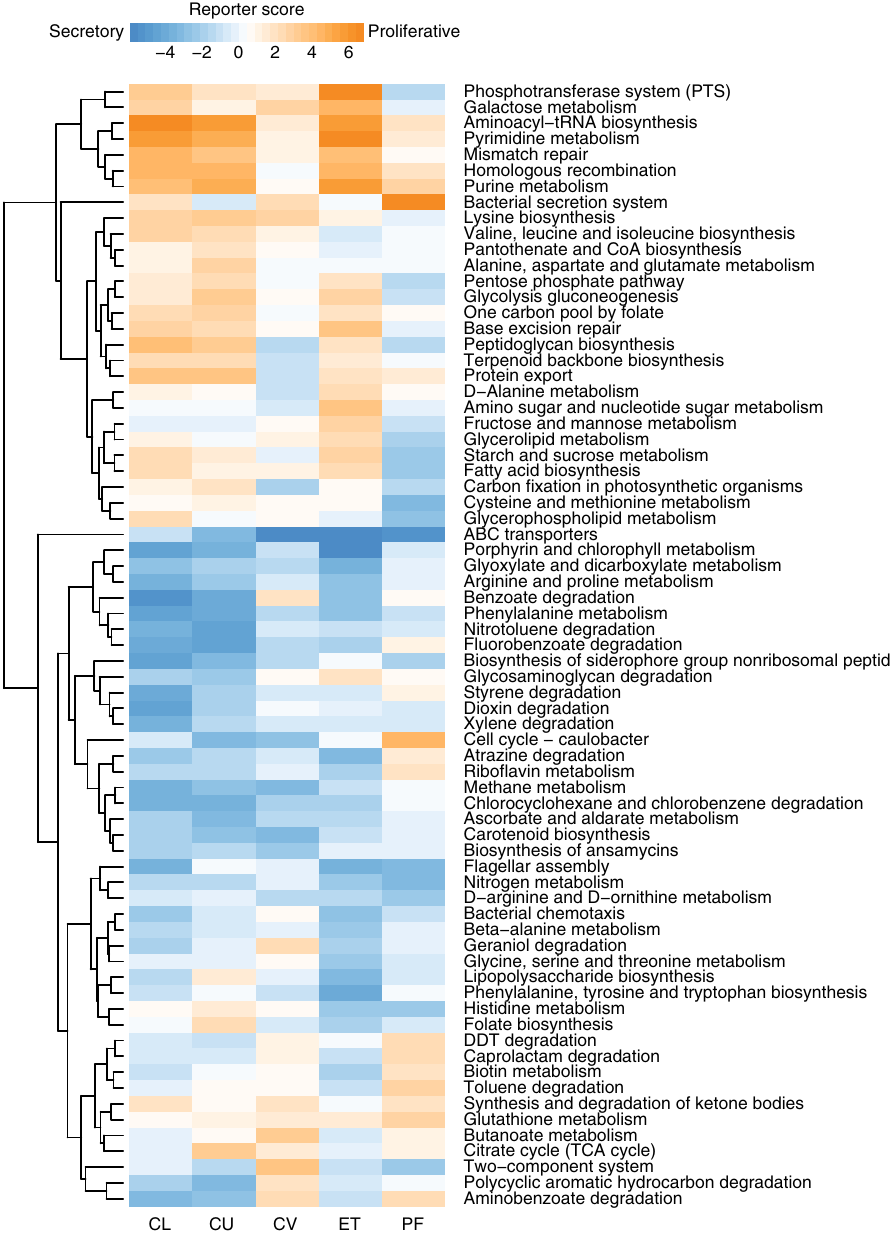
Fig. 6 Associations between inferred microbial functions and menstrual phases. Microbial KEGG pathways enriched in the proliferative or the secretory phases (orange versus blue, reporter score > 1.96 or < − 1.96) and present in all the body sites were plotted as a heatmap. The pathways were arranged by unsupervised hierarchical clustering. Samples derive from the study cohort of 95 reproductive-age women ( n = 94 CL, 95 CU, 95 CV, 80 ET, 93 PF, 9 FLL and 10 FRL, Supplementary Data